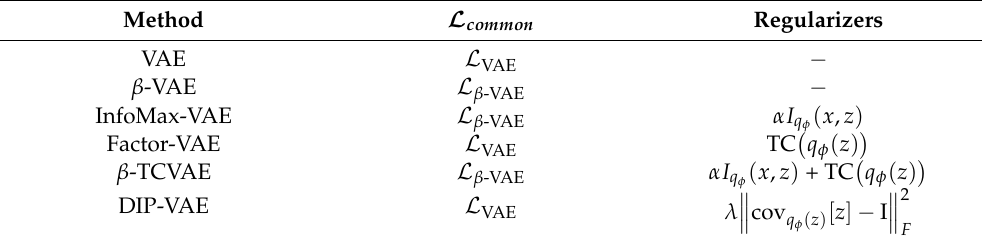
Table 4. Summary of different ELBO decompositions alongside the regularization applied. For each method, the learning objective is given by L common + regularizer .